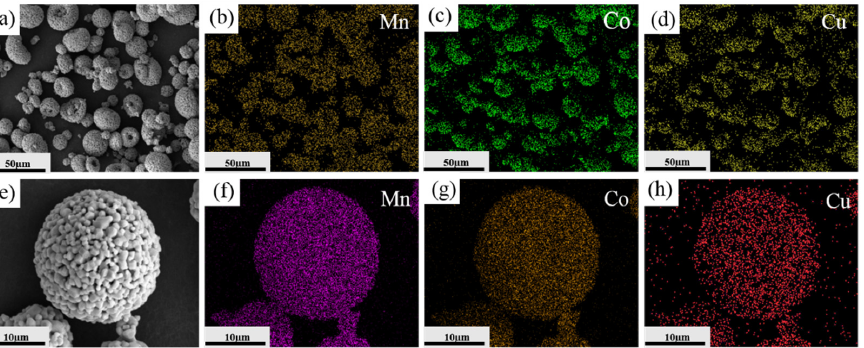
Figure 7. The morphology and elements distribution of Cu 0.3 Mn 1.5 − x Co 1.5 − y O 4 powders sintered at ◦ C for 12 h ( a – d ) low magnification; ( e – h ) high 1000 °C for 12 h ( a – d ) low magnification; ( e – h ) high magnification. 1000